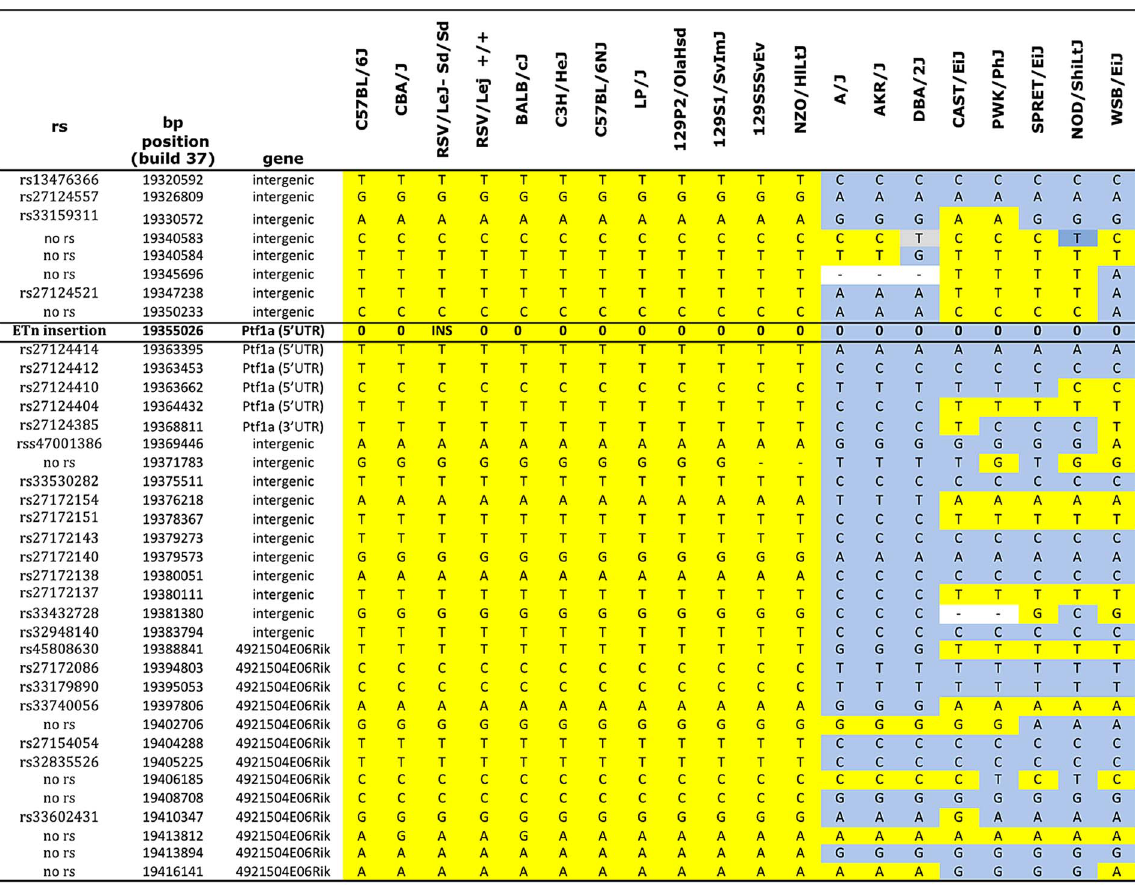
Figure 3. Haplotype map of the Ptf1a locus. Genotype data were obtained from the Mouse Phenome Database (Sanger data). All alleles identical to C57BL/6J are highlighted in yellow. Non- C57BL/6J alleles are highlighted in gray. The ETn insertion is indicated (INS). Missing genotypes are denoted by (-).